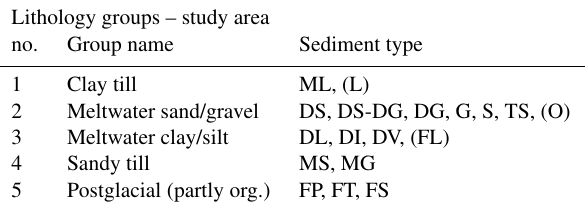
Table 1. Lithology groups in the study area used in the geostatisti- cal simulation. The sediment-type abbreviations in the right column represent the Danish sediment characterization